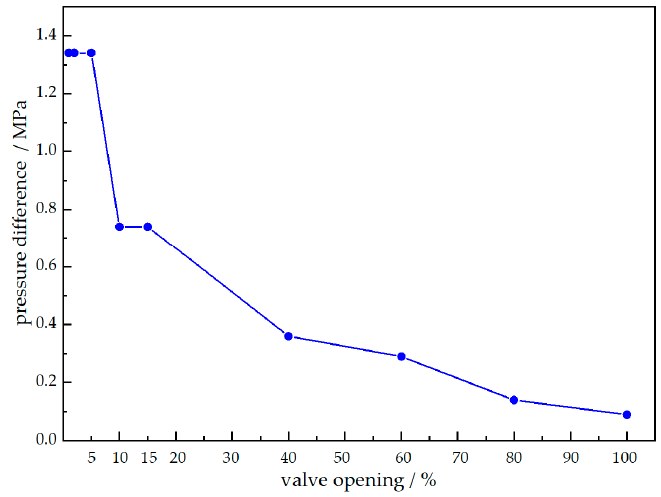
Figure 9. Pressure di ff erence across the valve core at di ff erent openings.